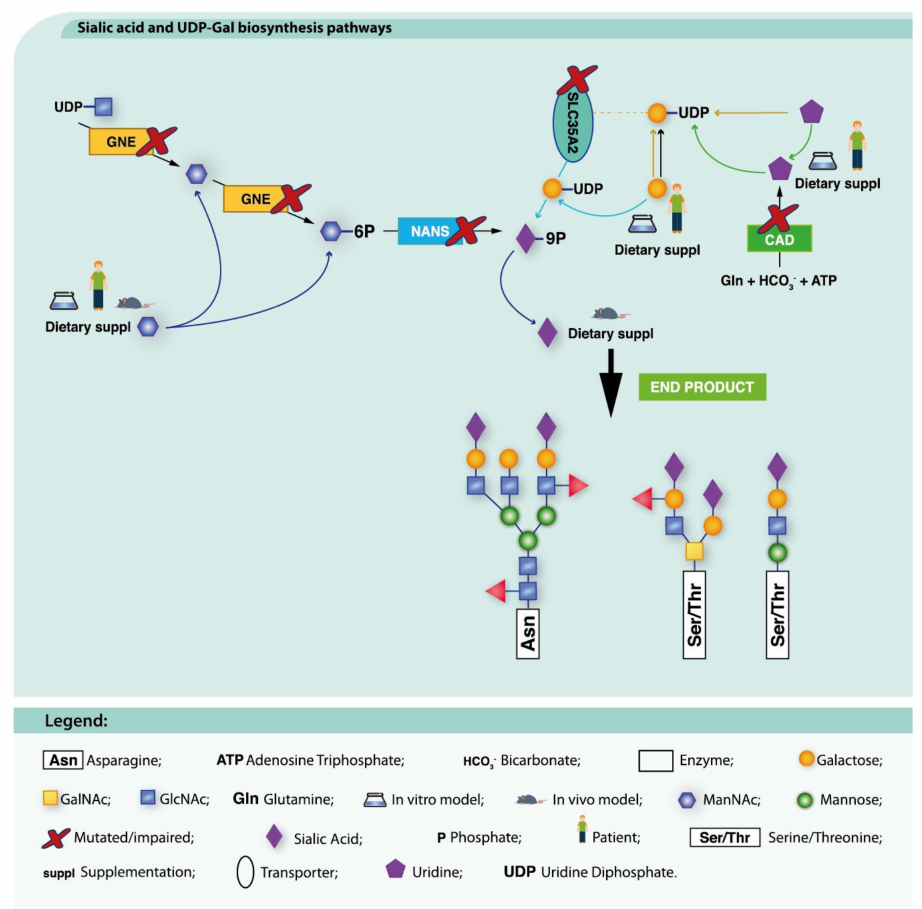
Figure 2. Dietary supplementation approaches under investigation for CAD-CDG, GNE-CDG, NANS-CDG and SLC35A2-CDG. Uridine supplementation has been tried for CAD-CDG (green arrow). Combined administration of uridine and Gal aims to increase Gal-UPD levels (yellow, green, black and light blue arrows). This allows the bypass of SLC35A2 transporter defect. ManNAc supplementation (dark blue arrow) has been used for GNE-CDG and NANS-CDG. These therapeutic approaches aim to recover the metabolic pathways (black arrows) and ultimately, the normal glycosylation profile (bold black